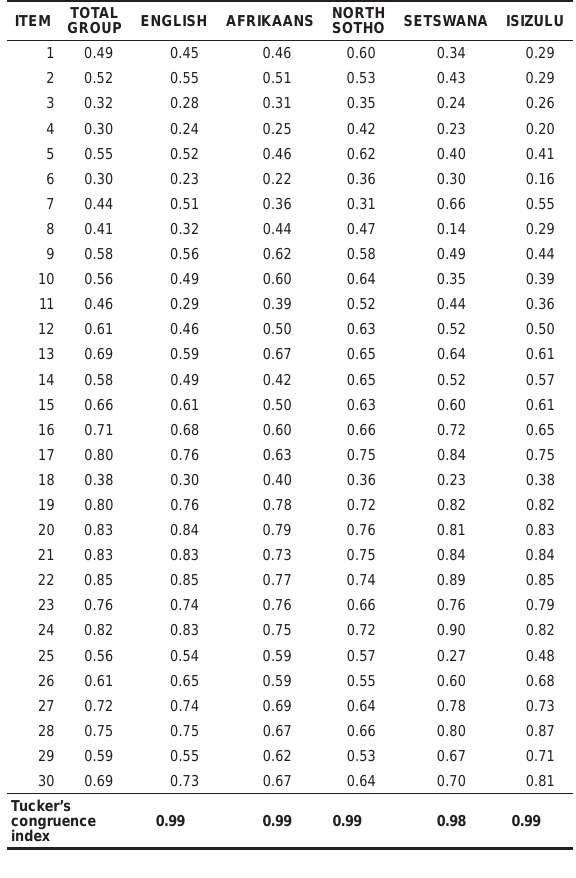
item total Group enGliSH aFrikaanS nortH SotHo SetSwana